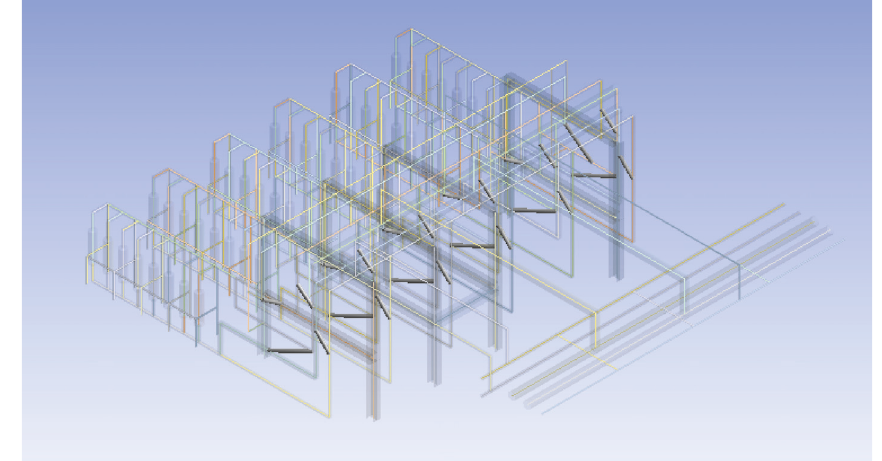
Figure 19: Additional constraints (3rd